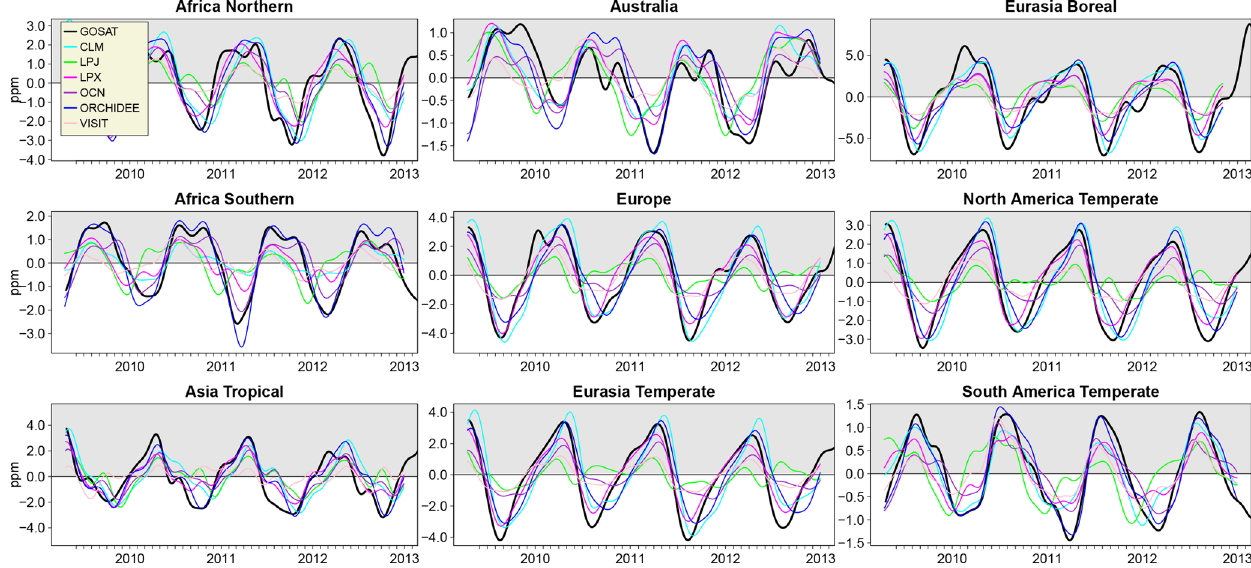
Figure 3. Detrended XCO 2 seasonal cycles by TransCom region. Simulated seasonal cycles are the sum of transported fluxes from DGVM, fossil fuel and ocean, but only the DGVM model name is